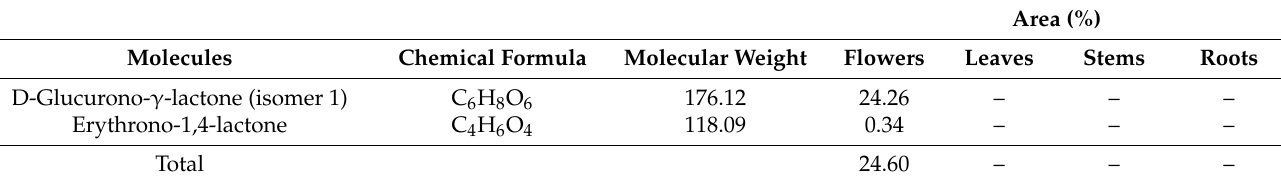
Table 4. Lactones of derivatized methanolic extracts obtained by GC-MS.